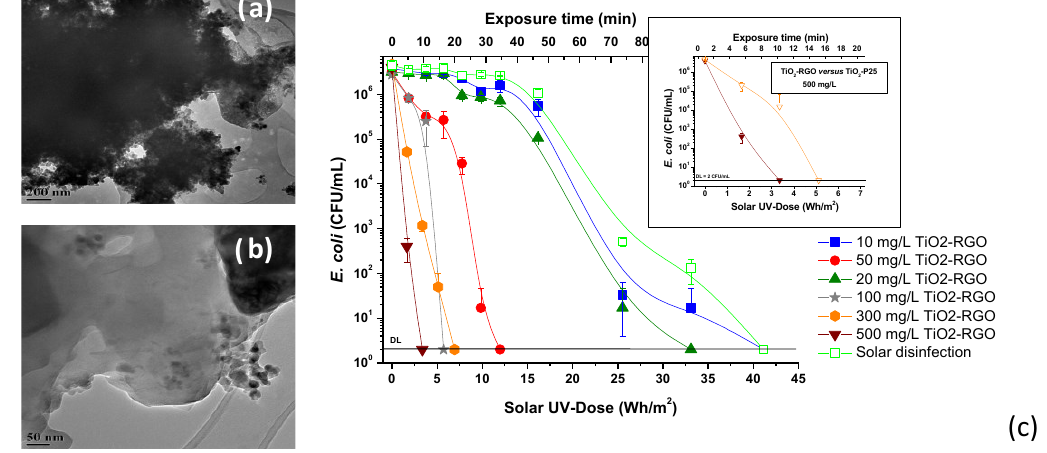
Figure 5. ( a ) TiO 2 -GO aggregate before photoreduction; ( b ) TiO 2 -RGO after UV assisted photoreduction and ( c ) E. coli inactivation at several TiO 2 -RGO concentrations. Figure inserts shows efficiency of TiO 2 -RGO and TiO 2 -P25 on the E. coli inactivation